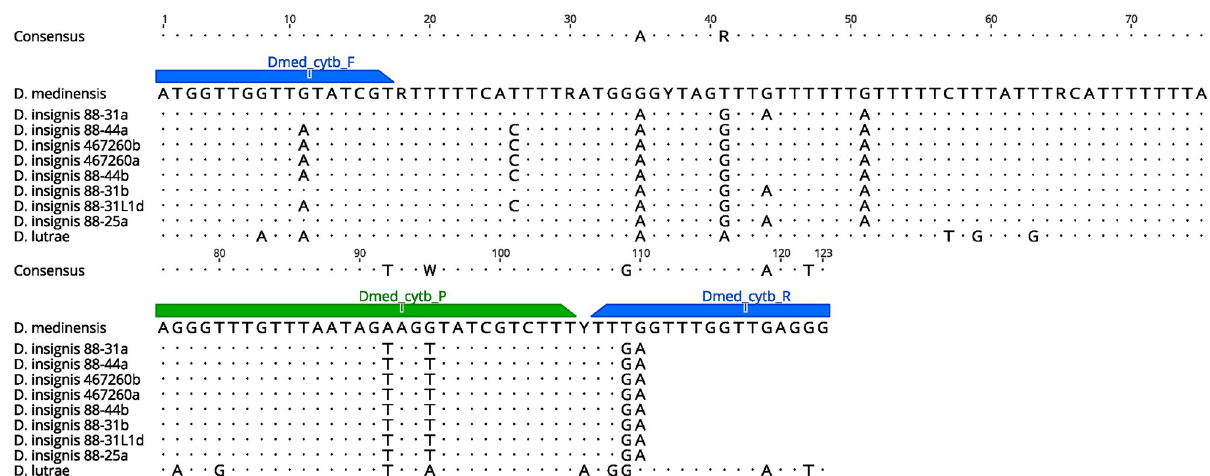
Fig 1. Alignment of partial (123-bp) cytb gene for three Dracunculus species demonstrating the in silico specificity of the qPCR primers (Dmed_cytb_F/R) and probe (Dmed_cytb_P).